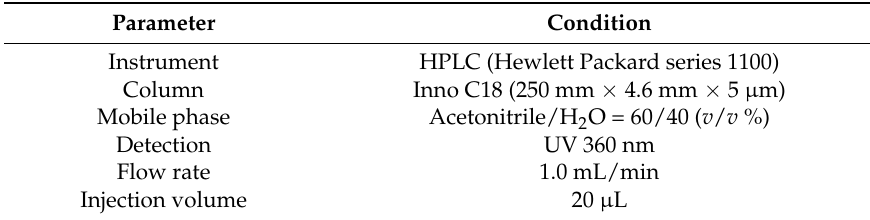
Table 3. Conditions for formaldehyde analysis using